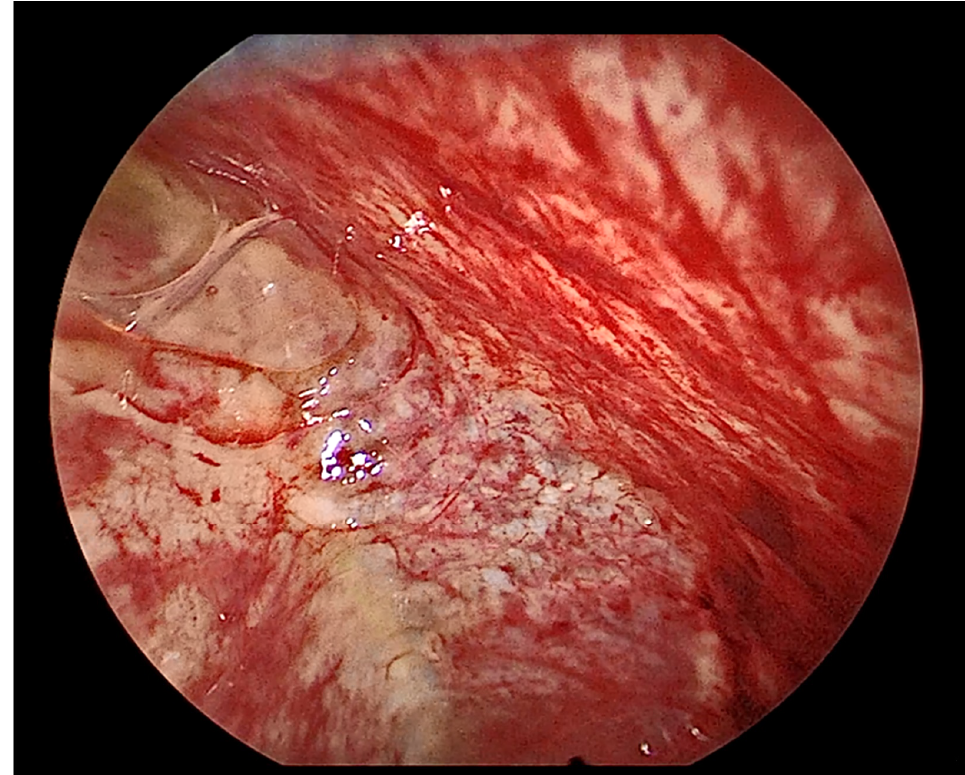
Figure 15. Thoracoscopic view of a severely inflamed pleura.